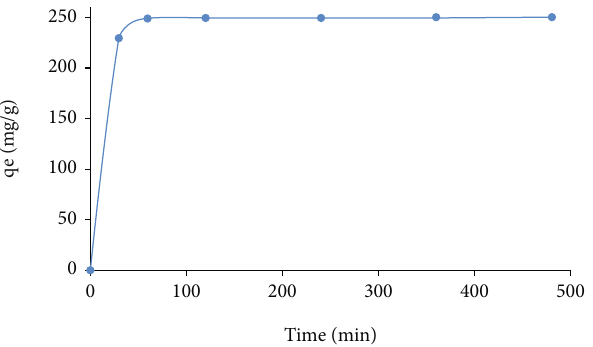
Figure 5: E ff ect of time on the adsorption of safranin on polymeric hydrogel (adsorbent dosage 0.01g, dye solution 10mL, time 30 – 480 min, pH = 11 , temperature 313